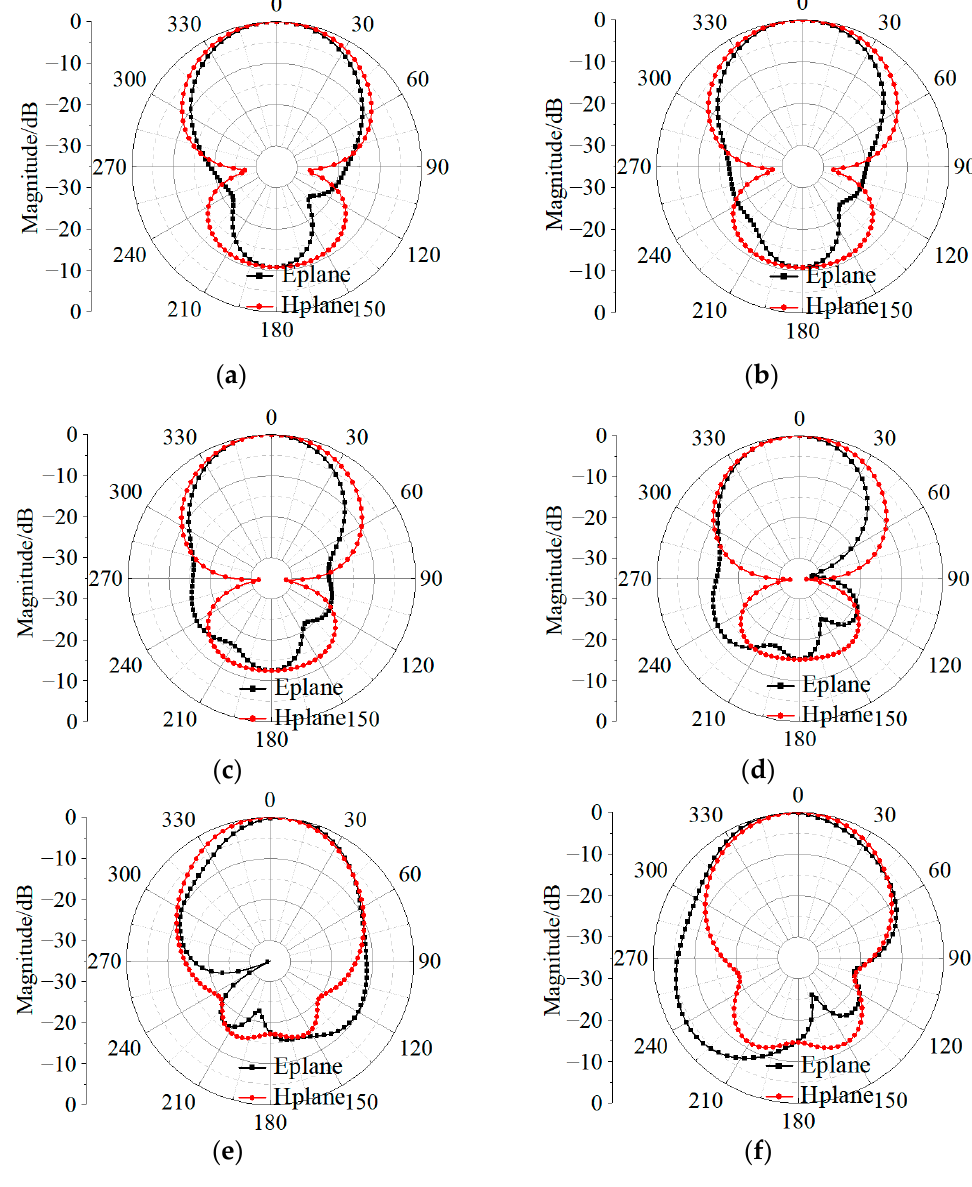
Figure 9. Radiation patterns of the proposed antenna at ( a ) 13 GHz, ( b ) 14 GHz, ( c ) 15 GHz, ( d )16 GHz, ( e ) 17.5 GHz, and ( f ) 18 GHz.